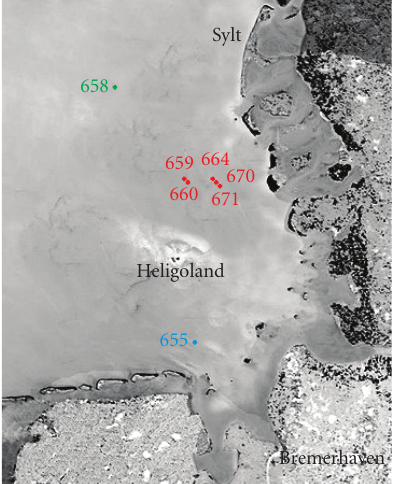
Figure 1: Satellite image of the German Bight showing the locations of the seven sampling sites (Image: ESA/NASA - SOHO/LASCO). Samples taken during an algal bloom (samples 659, 660, 664, 670, and 671) are shown in red. Sample 655 taken at a river outfall and sample 658 originating from outside the algal bloom in blue and green,